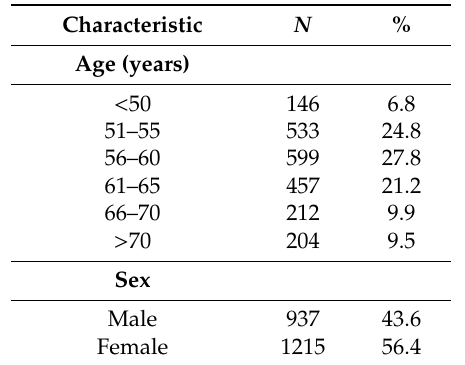
Table 1. Demographic characteristics of sample population ( N =